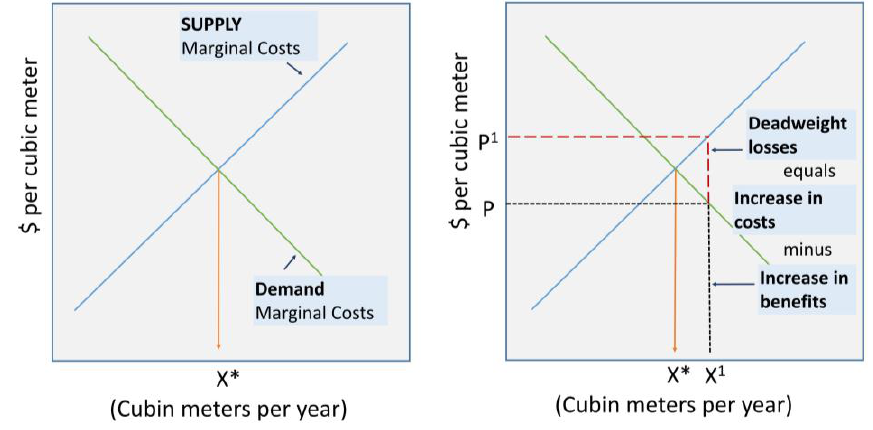
Figure 2. Optimal consumption (left) and “deadweight losses” if water is underpriced (right) [19].